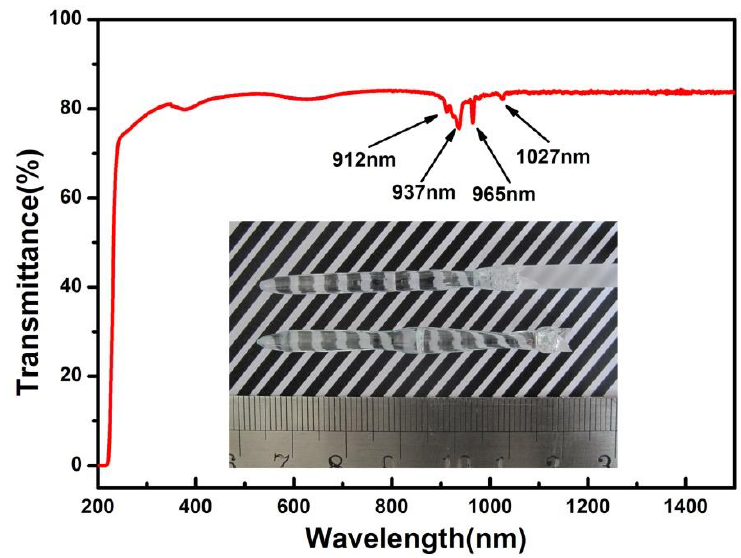
Figure 3. In-line transmittance of LuYAG crystals (inset: appearance of as-grown crystal).